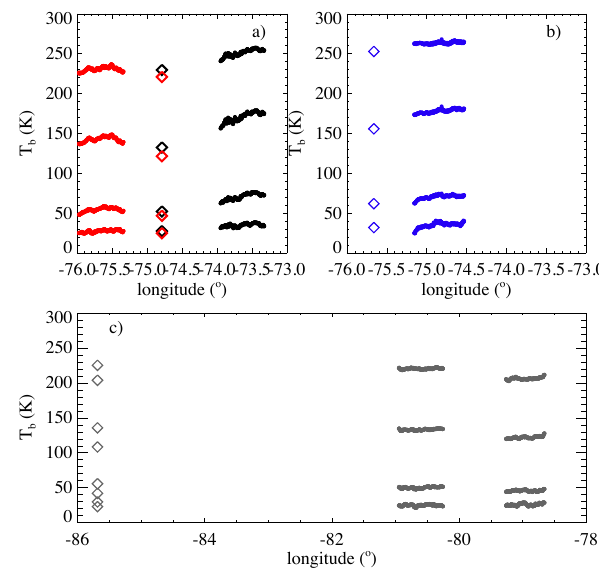
Fig. 7. (a) Two 2 November above-cloud overpasses, RF8 AC2 and AC4, occurring at 07:04:20 and 08:03:20 UTC, and 1.38 and 1.6km altitude, shown using black and red time series traces respec- tively for all four channels, with the warmest values corresponding to the ± 1GHz channel. The T b s simulated from a ship-launched radiosonde at 07:22:20 UTC at 1380 and 1600 m altitude are shown as black and red diamonds respectively. (b) measured T b s during a 11 November, 19:59:40 overpass (RF12) at 1410m altitude and calculated T b s from a radiosonde launched at 20:50:00 UTC (dia- monds). (c) measured T b s from above-cloud legs on 25 October (RF5) at 09:22:00 and 12:47:00, and T b s calculated from radioson- des launched at 07:23:00 and 11:16:00 UTC (diamonds).